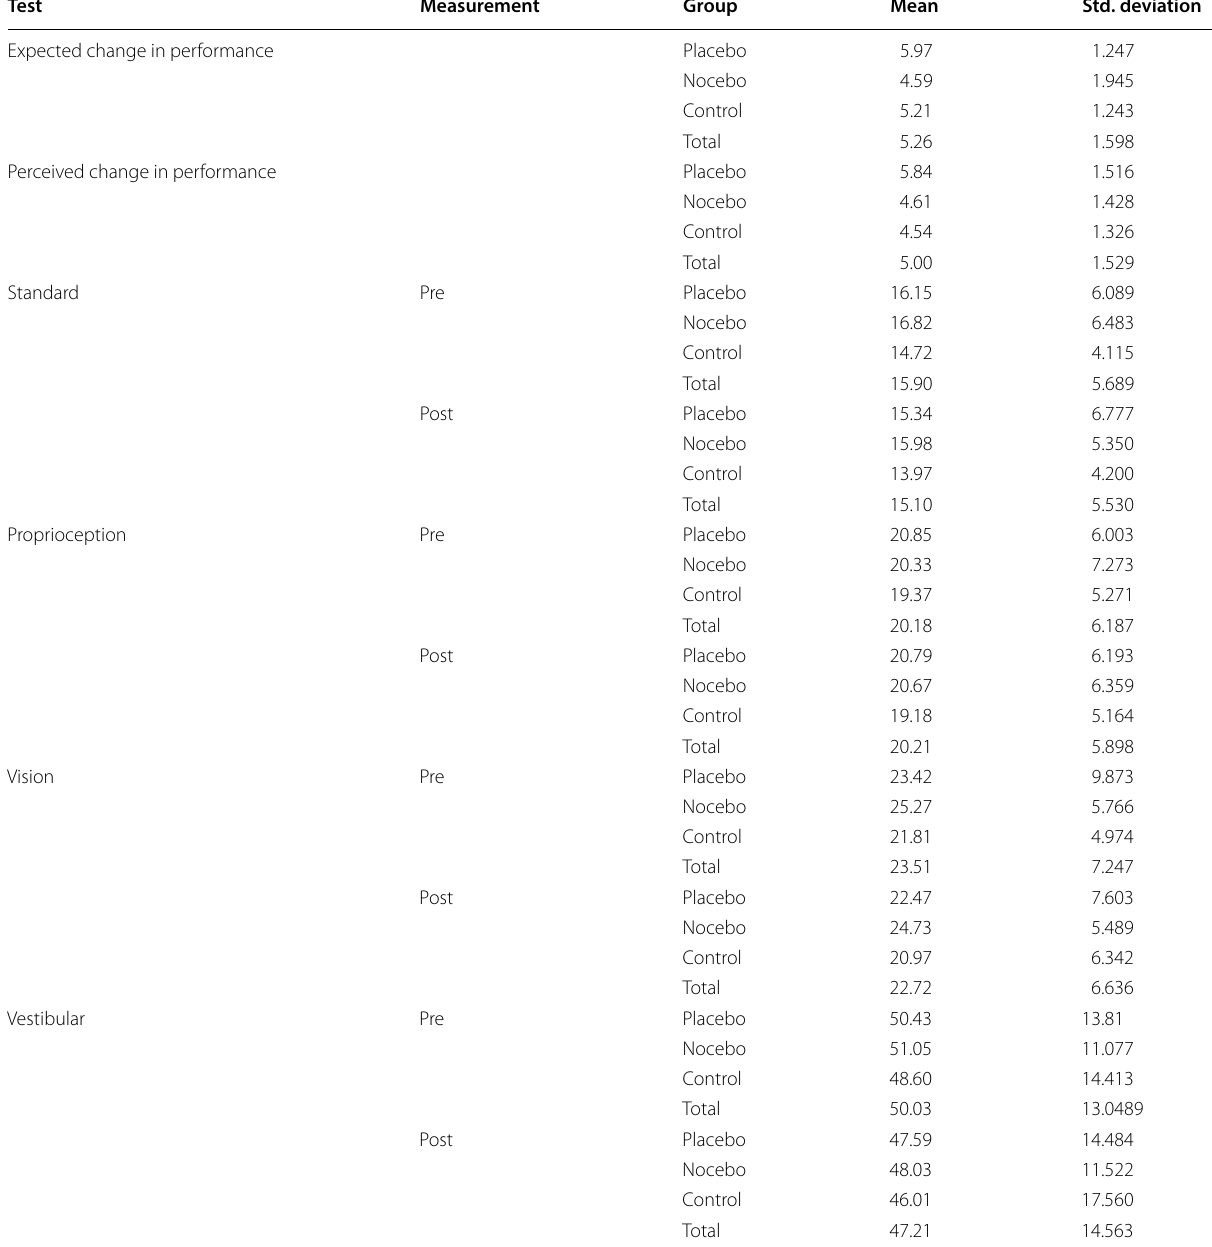
Table 2 Performance indices of the investigated variables by experimental groups Test Measurement Group Mean Std. deviation Expected change in